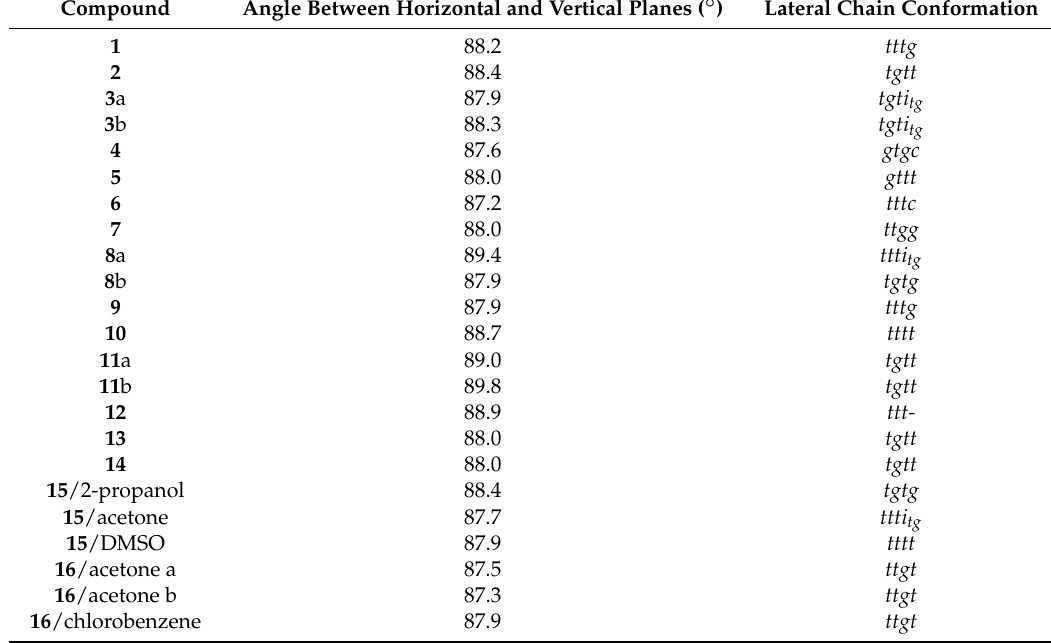
Table 7. Values of the angles between the horizontal and vertical planes, and conformations of the lateral chain in the steroids analyzed in this paper (a and b refer either to the two molecules in the asymmetric unit, or to the two monomers in a dimer).